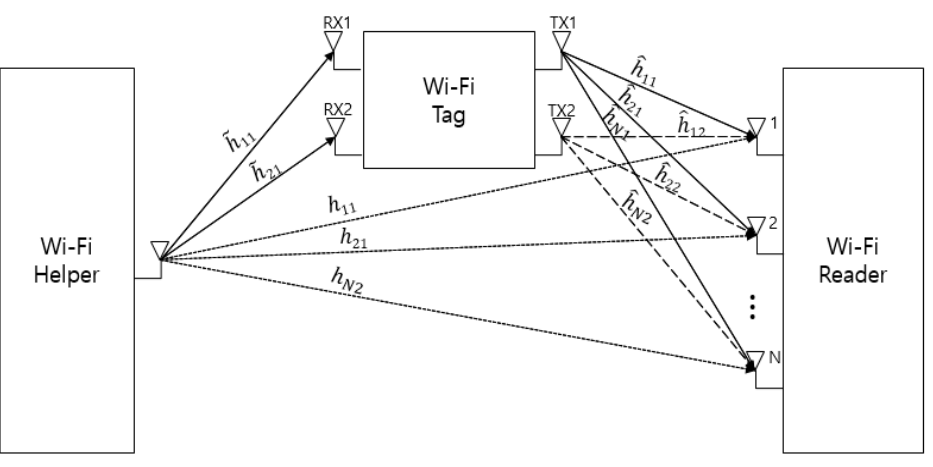
Figure 3. Modeling of channel environments in the proposed system.